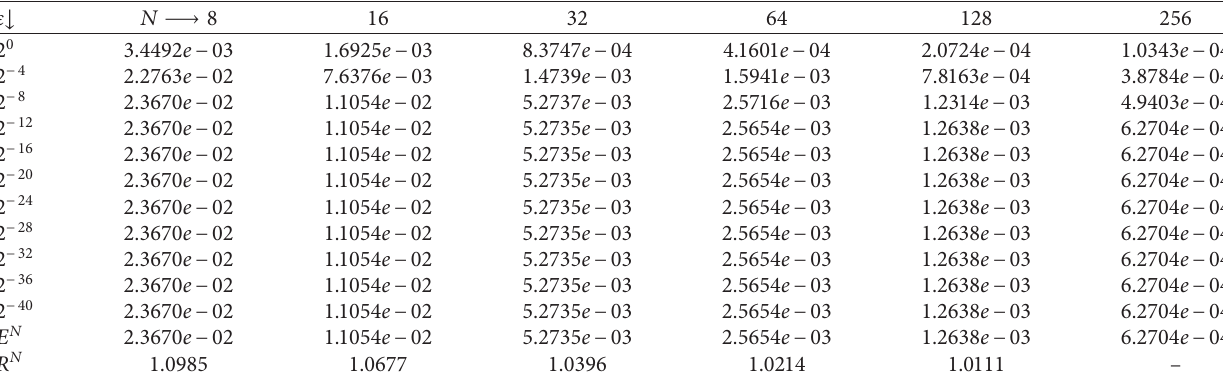
Table 3: Maximum absolute error of Example 2 before Richardson extrapolation for δ � 0 . 6 ε and η � 0 . 5 ε